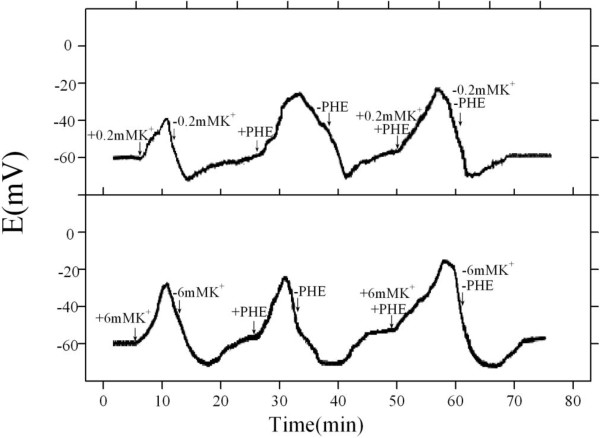
Phenanthrene-, potassium-, or phenanthrene plus potassium-induced membrane potential changes. Impalements were made in basal solution (5 mM MES, 0.5 mM CaCl2, 0.05 mM NaCl, pH 5.5) with or without 5.62 μM phenanthrene, potassium, or 5.62 μM phenanthrene plus potassium. Wheat roots grew for 15 d. Arrows indicate times at which addition and removal of phenanthrene, K+, or phenanthrene and K+. MES, 2-(N-morpholino)ethanesulfonic acid. PHE, Phenanthrene.